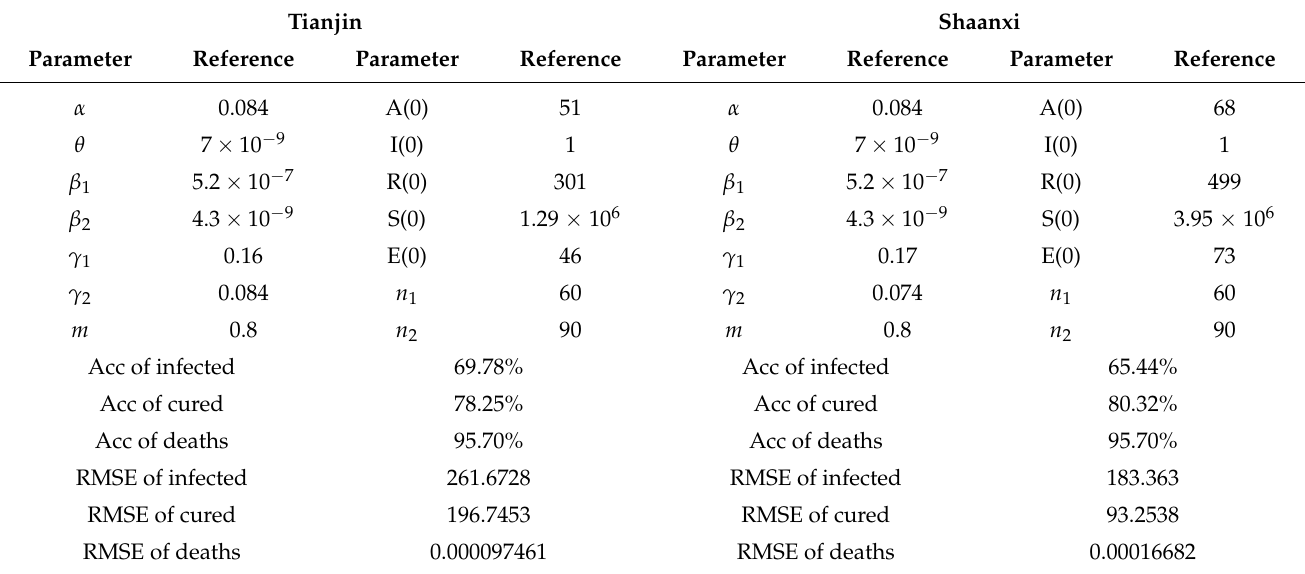
Table 5. Summary of parameters and average accuracy results.